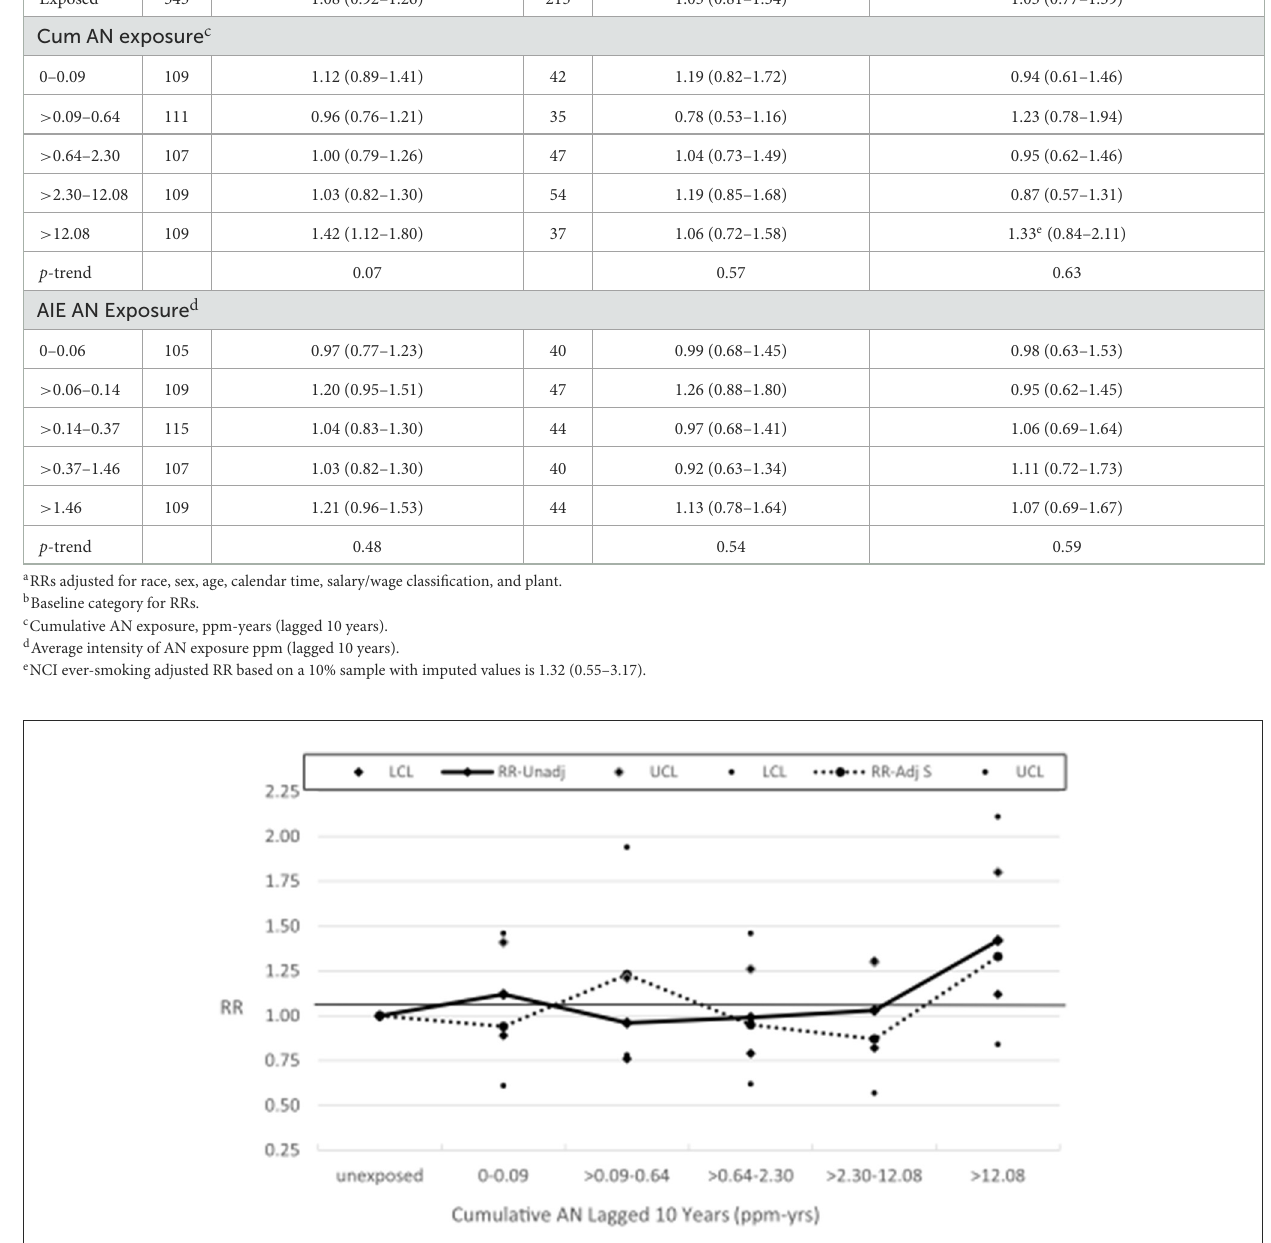
FIGURE2 UPitt lung cancer relative risks (RR) by cumulative AN exposure, unadjusted and adjusted for confounding by smoking using the Richardson method.